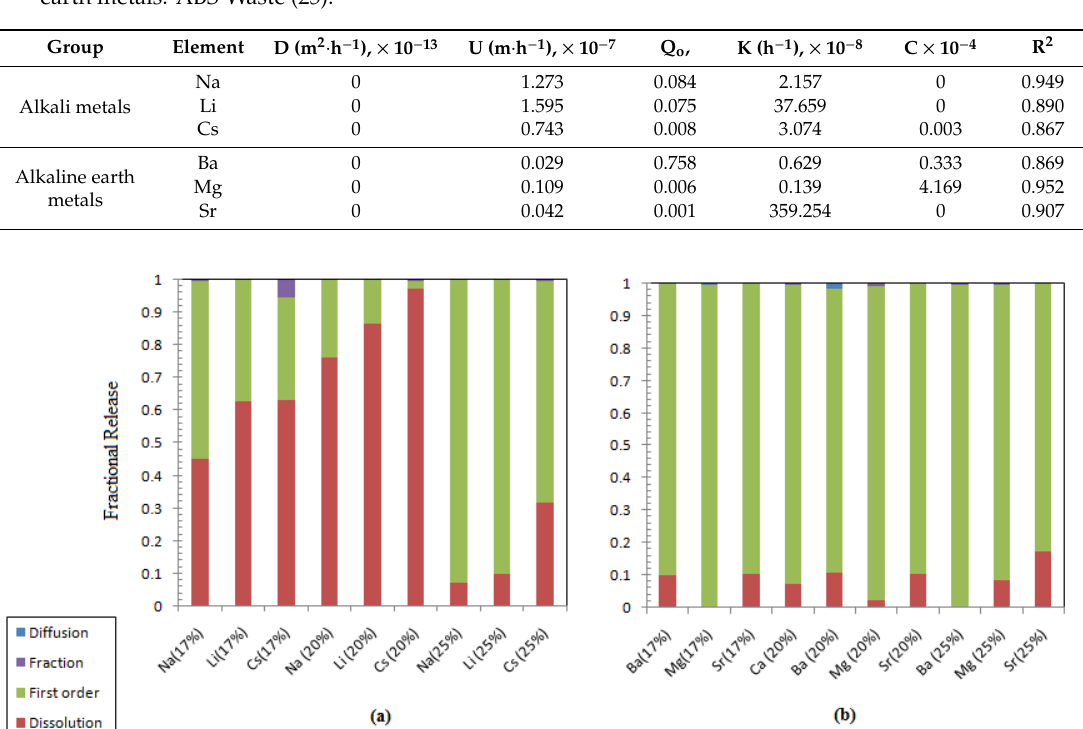
Figure 8. Contribution of different leaching processes to the fractional release: ( a ) alkali elements; ( b ) alkaline earth metals.